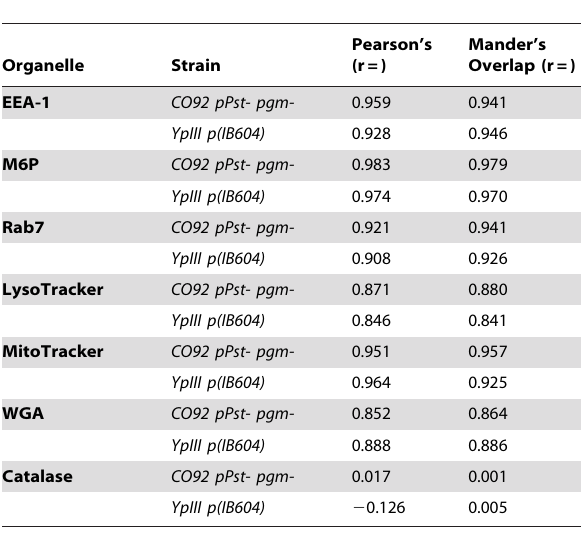
Table 2. Co-localization analysis of IFM intracellular V trafficking.